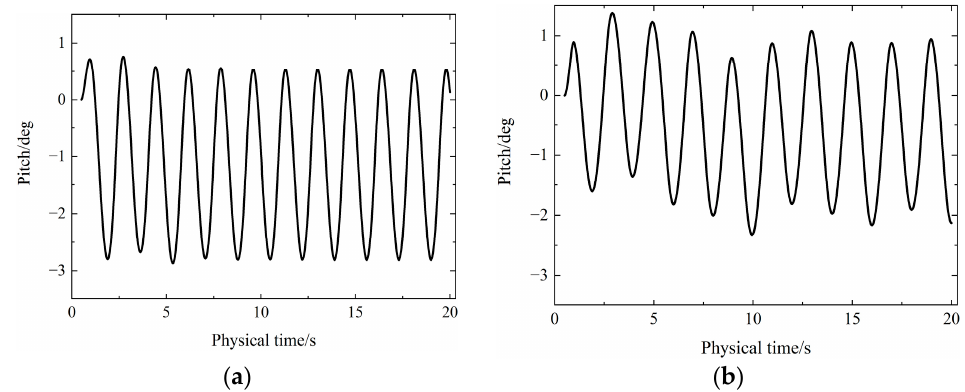
Figure 24. The time history curve of pitch angle under case 6: ( a ) monohull; ( b ) pentamaran.